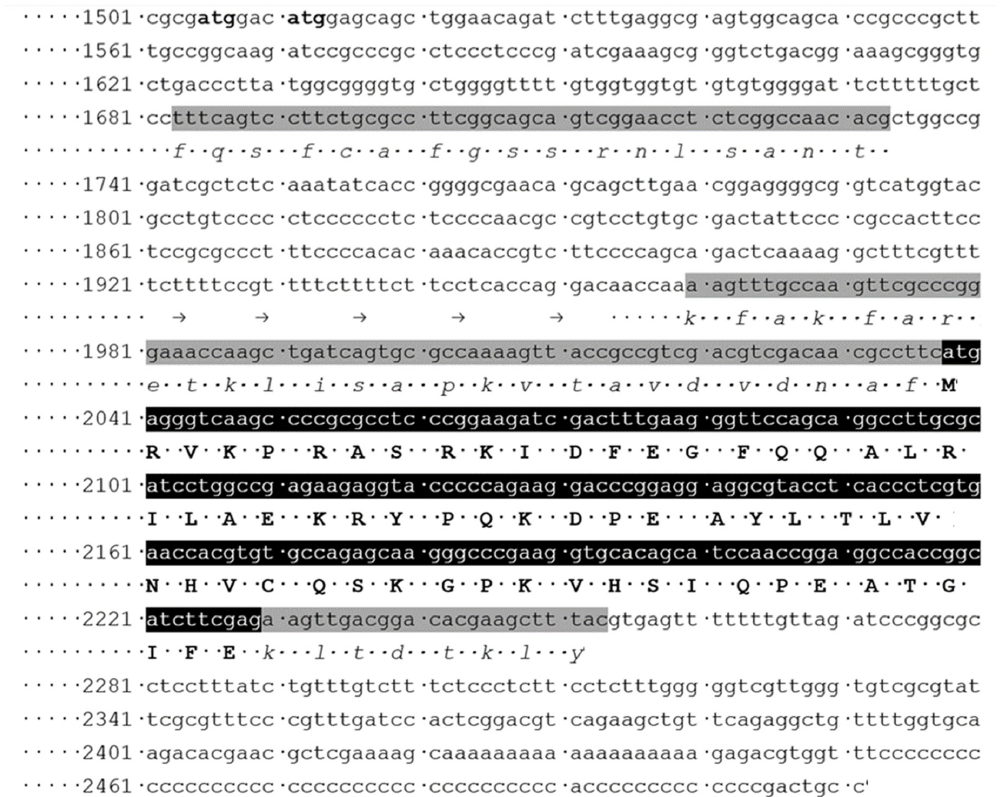
Figure 2. Partial sequence of Olpidium bornovanus isolate S191 BJ554k121_659286, whole genome shotgun sequence (GenBank: JAEFCI010004592.1). Numbers indicate the order of its nucleotides. Black background indicates the nucleotides corresponding to the KAG5460860, hypothetical protein. Bold capital letters show the amino acid sequence of this protein. Gray background indicates nucleotides whose translation are shown in Figure 3. The corresponding amino acids are shown with lower case italic letters. The possible positions of the initiation codon (atg) are labeled by bold